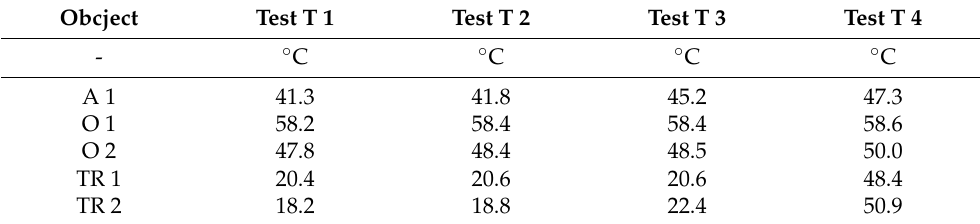
Table 6. Measurement results of temperature increments ∆ T for individual